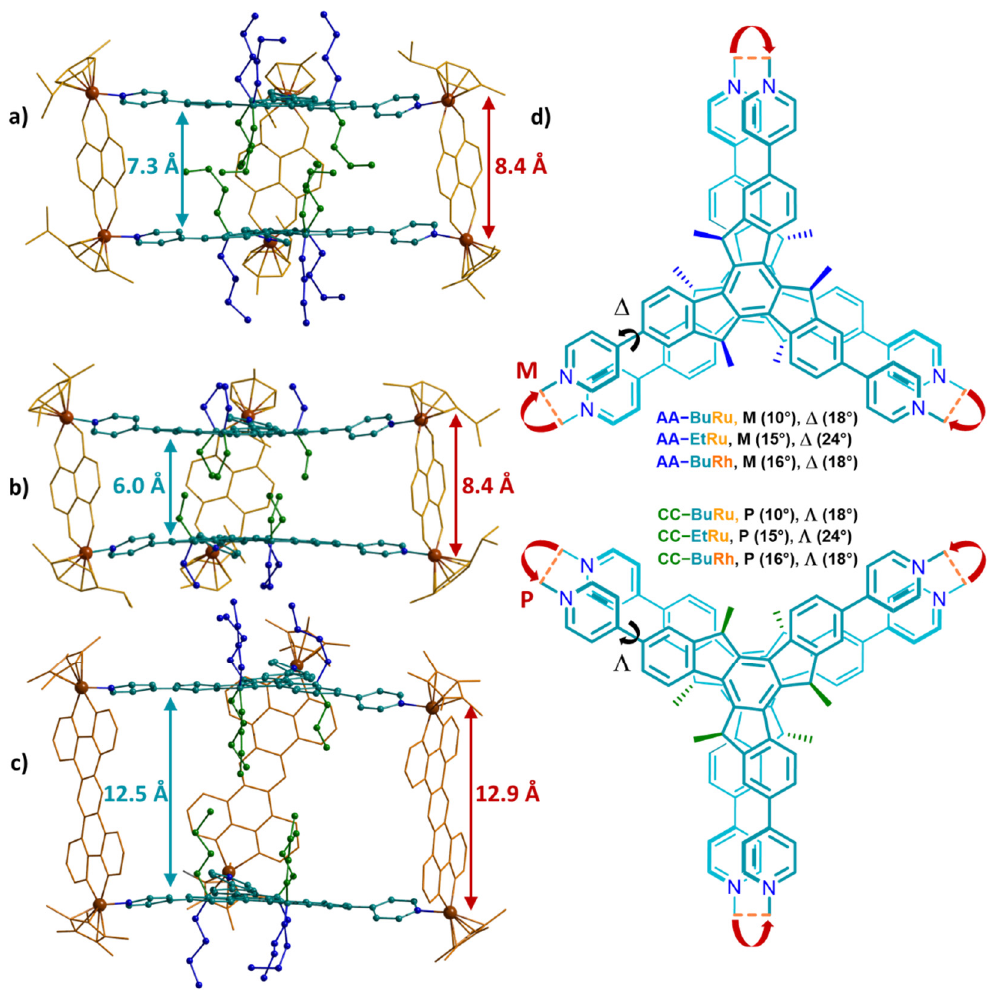
Figure 5. X-ray crystal structures of: ( a ) BuRu ; ( c ) BuRh and MM+ simulation of ( b ) EtRu (only CC forms are represented). Schematic representation of chirality elements ( d ).